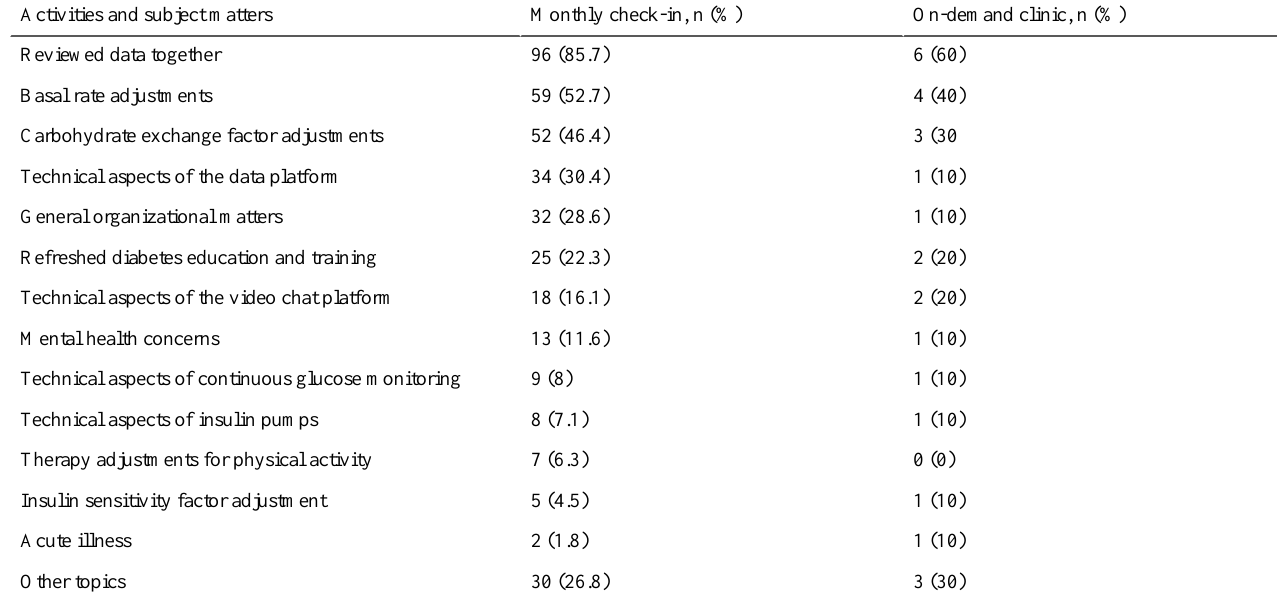
Table 2. Activities and subject matters that were discussed during remote care